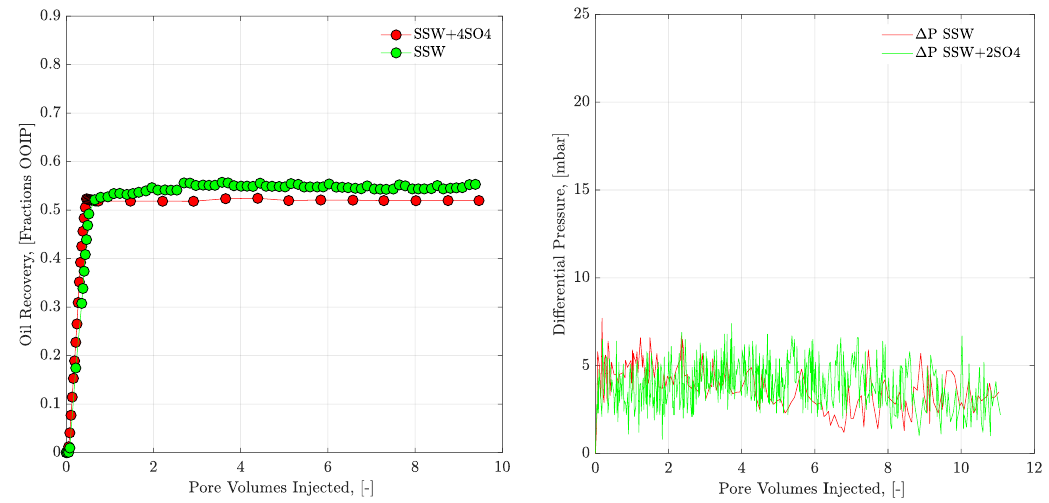
Figure 15. Oil recovery and pressure drop versus PV injected for water-wet artificial structure micromodel. Two injection brines of Table 2 are flooded as the secondary mode.